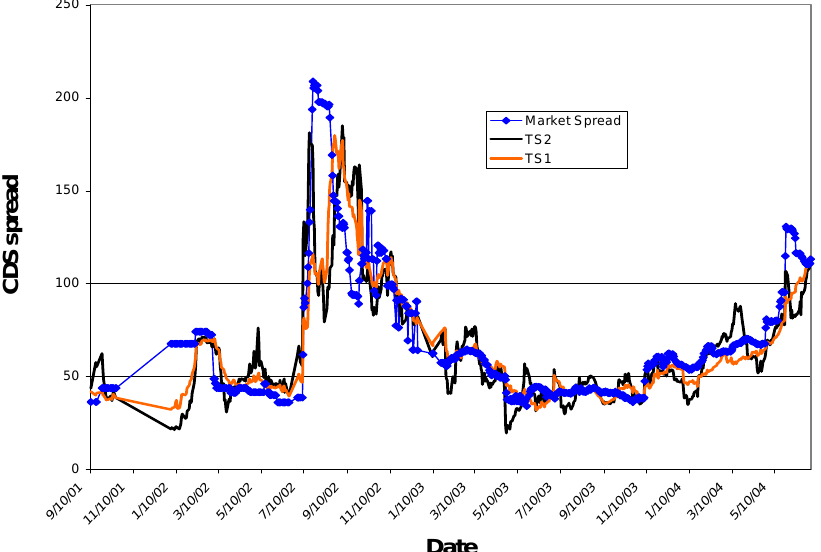
Figure 2. Wyeth, CDS spread, TS2 vs. TS1. Figure 2 presents the market CDS spread, modeled CDS spread computed with TS2, and CDS spread computed with TS1. It is shown that TS1 has a much tighter fit than TS2. However, it turns out that the trading performance of TS2 is better than that of TS1. TS2 gives more trading signals than TS1. J. Risk Financial Manag. 2016 , 9 , 3